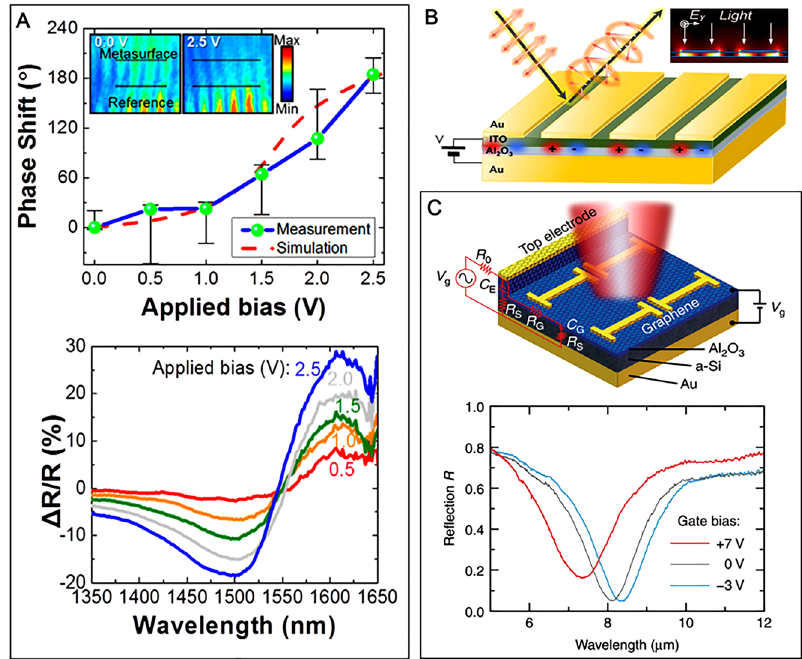
Figure4: Tunablemetasurfacesbasedonthe electrically driven carrier movement in ITO, graphene, and thin transition metal dichalcogenides